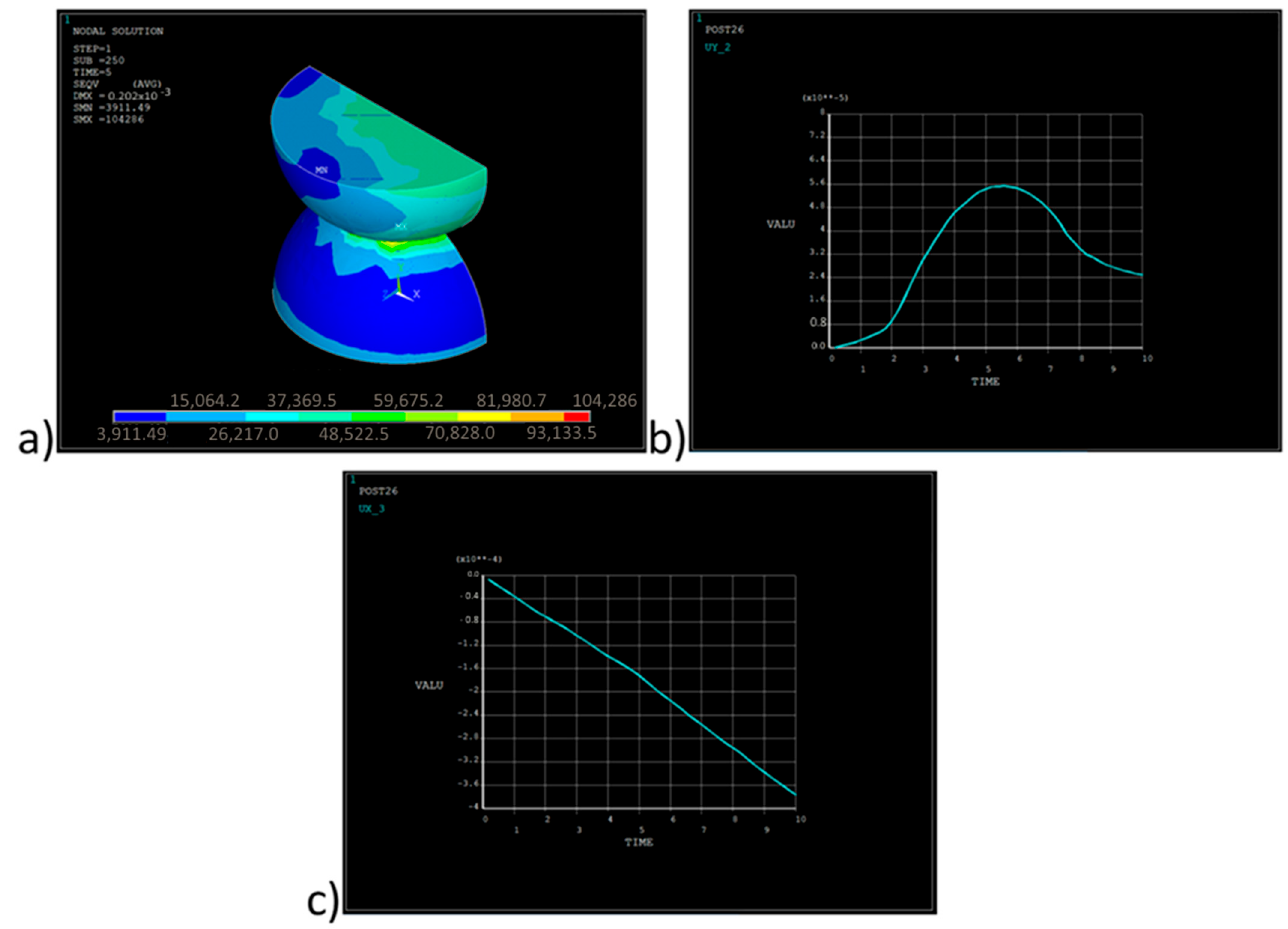
Figure 23. ( a ) Distribution of von Mises stress for contact between PTFE hemisphere and steel hemisphere; ( b ) Course of displacement in the X direction against time for the peak node of polyoxymethylene hemisphere; ( c ) Course of displacement in the X direction against time for the mentioned peak node.